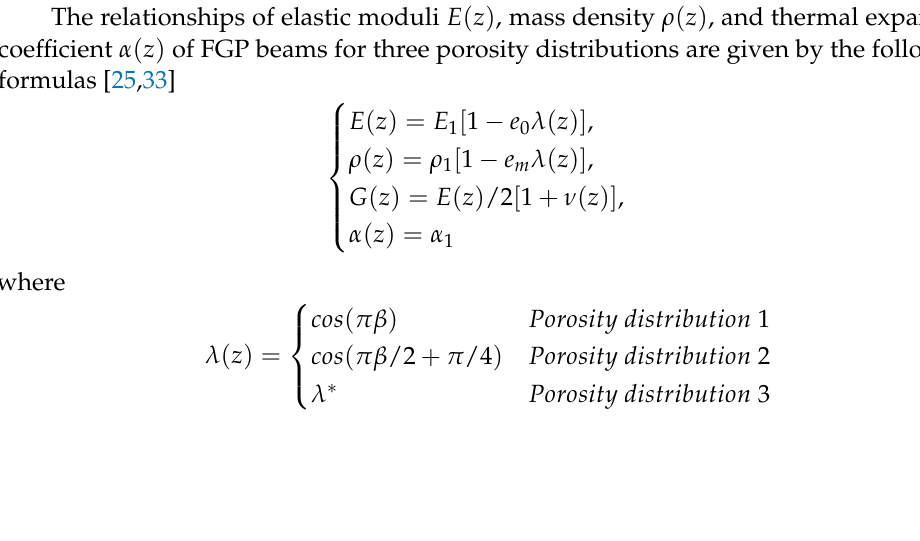
Figure 2. GPL patterns and porosity